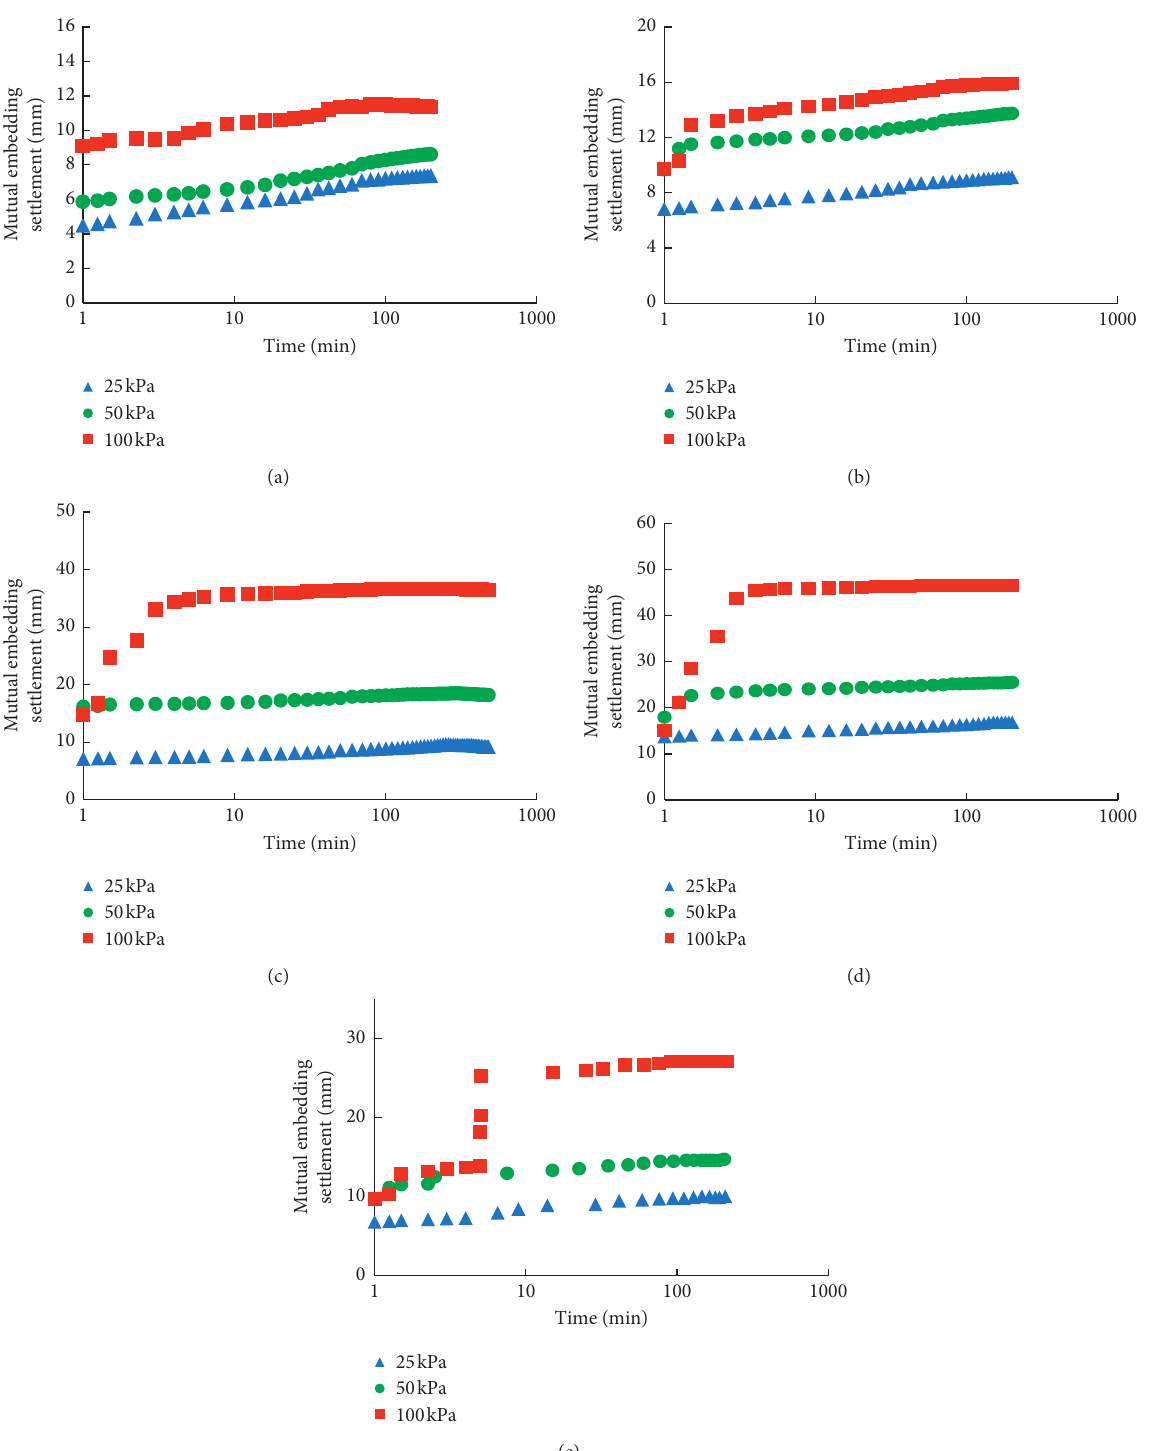
Figure 6: Mutual embedding settlement: (a) 15mm cement balls; (b) 25mm cement balls; (c) 35 mm cement balls; (d) 45mm cement balls; (e) 25mm glass